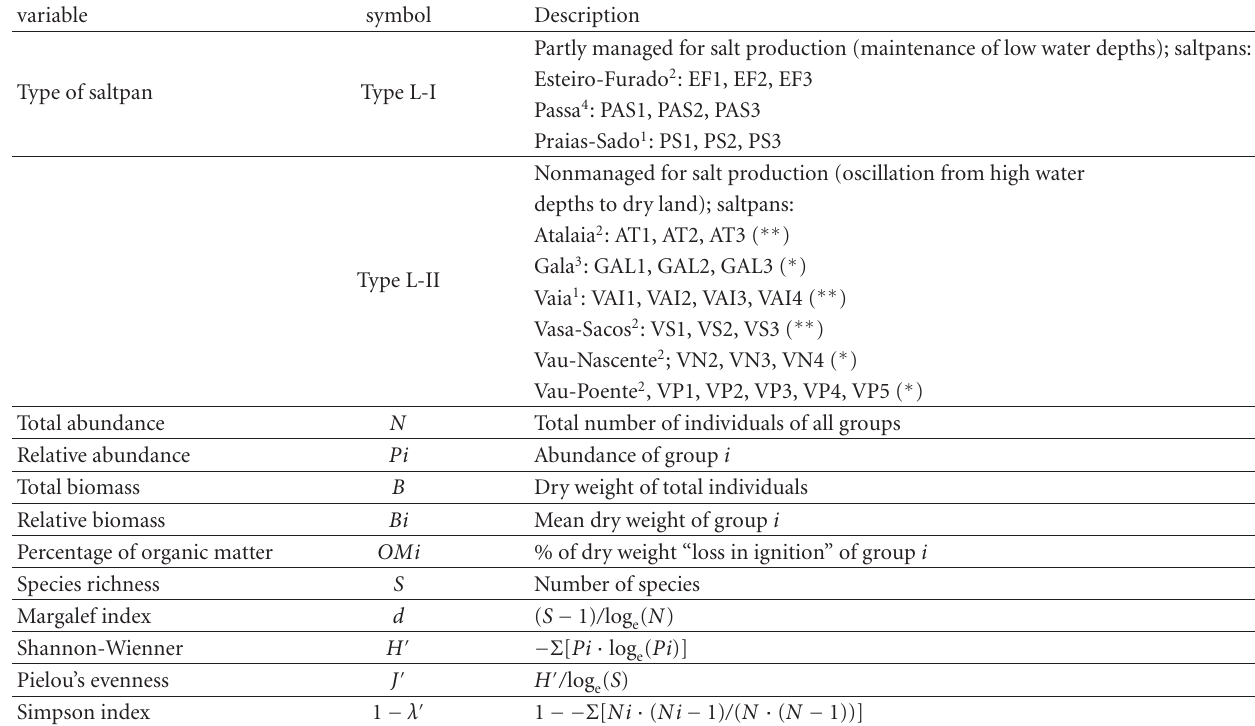
Table 1: Description of type of saltpan, variables, and indices.